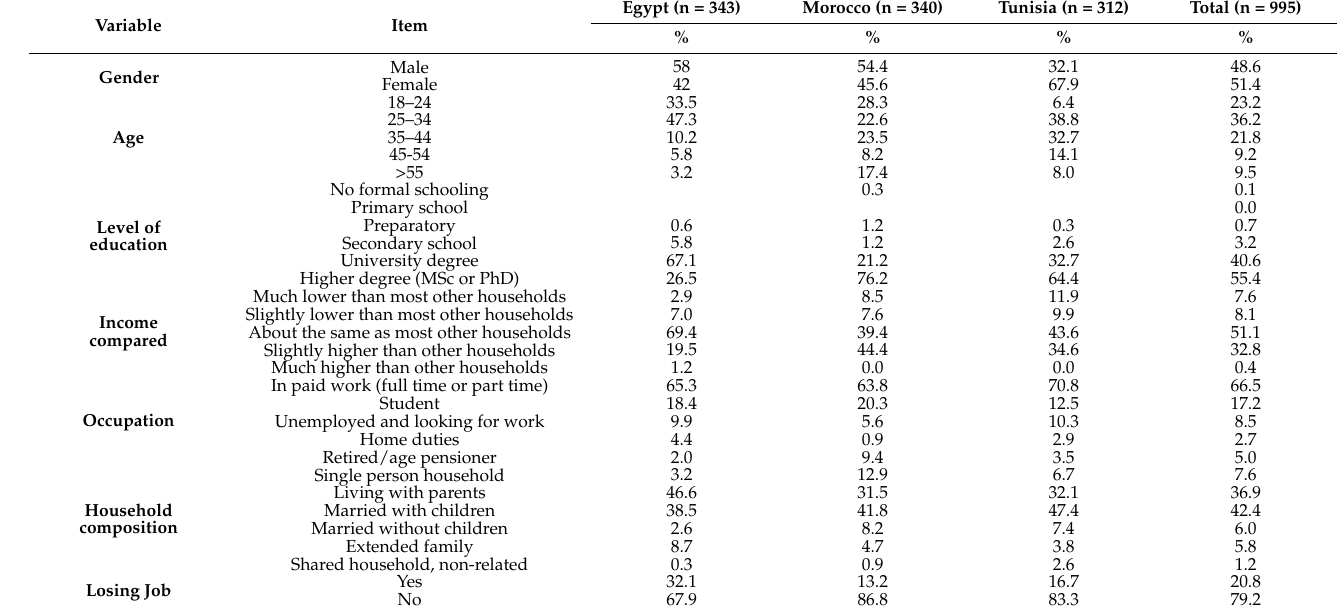
Table 1. Socio-demographic characteristics of the study participants (n =